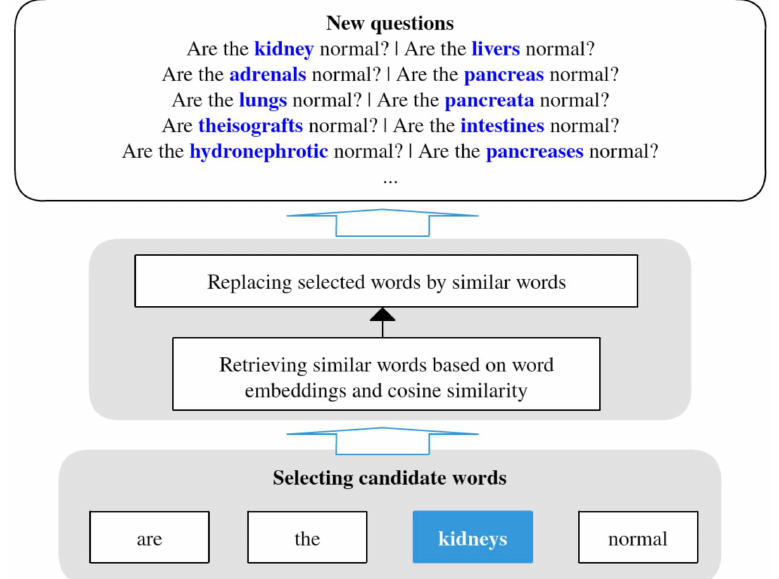
Figure 4. Contextual augmentation, when a clinical question “Are the kidneys normal?” is aug- mented by replacing only selected words with similar words retrieved based on the cosine similarity and pretrained word